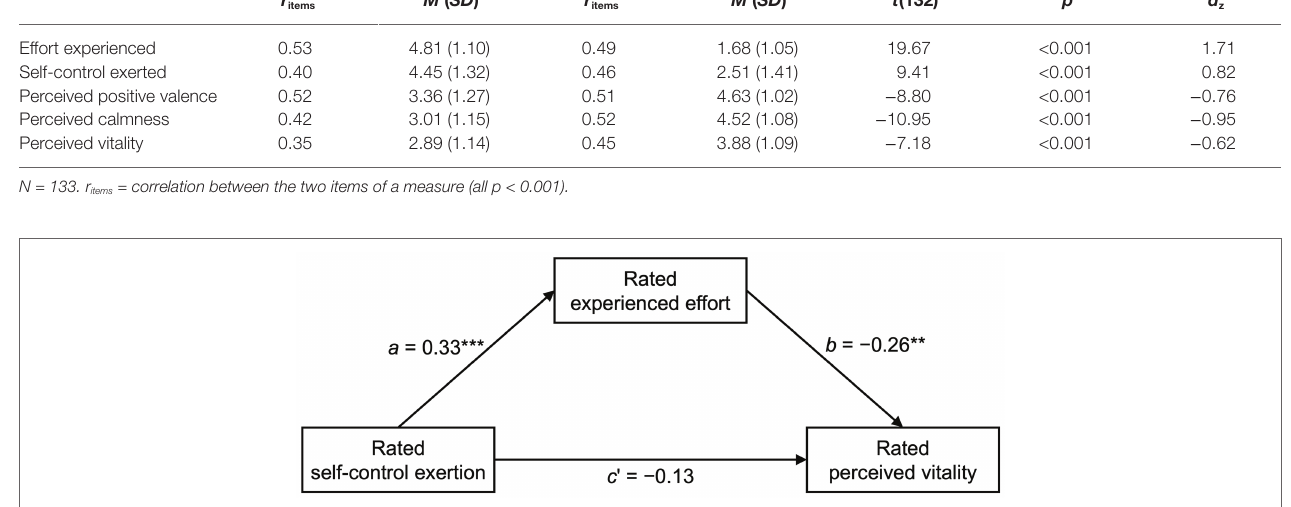
TABLE 1 | Descriptive statistics and mean comparisons between the ratings in the self-control condition and no-self-control condition in Study 1. Rating of the fictitious Self-control individual